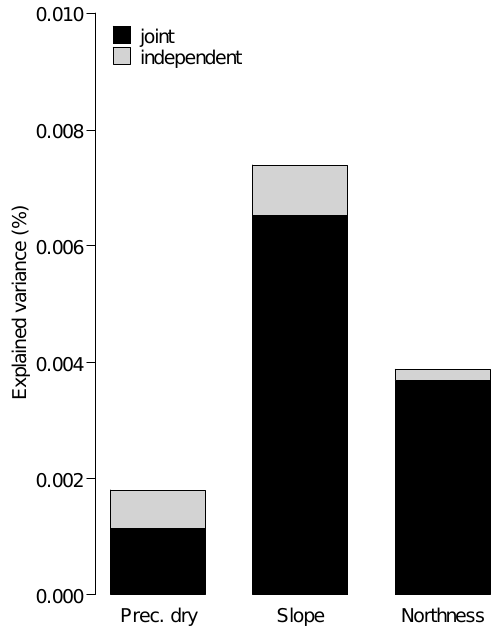
Figure 6. Hierarchical partitioning of the variance in fire presence/absence explained by precipitation of the driest month, slope and northness, into joint and independent